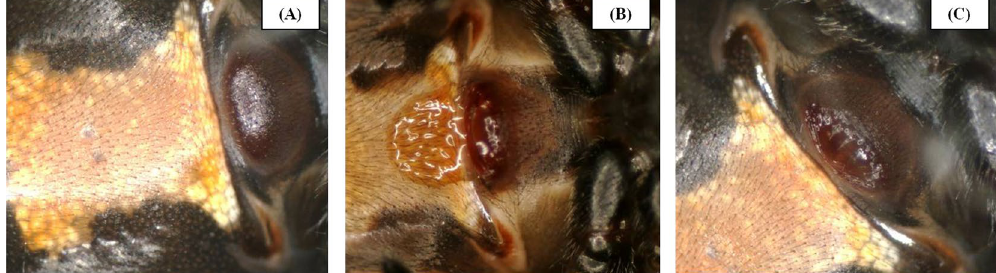
Figure 1. The external genitalia of L . hasselti females, located on the ventral surface of the abdomen just anterior to the upper margin of the ‘hourglass’ marking, and epigastric furrow. In all images, the posterior is left, anterior is right. ( A ) Protuberant genital region of an immature female two days before molt to adulthood; no external openings are present. ( B ) Genital region of immature female after mating with an adult male with haemolymph visible leaking from the region that was opened by the male. ( C ) Epigynum (mature external genitalia) of an adult unmated female with genital openings uncovered following the final